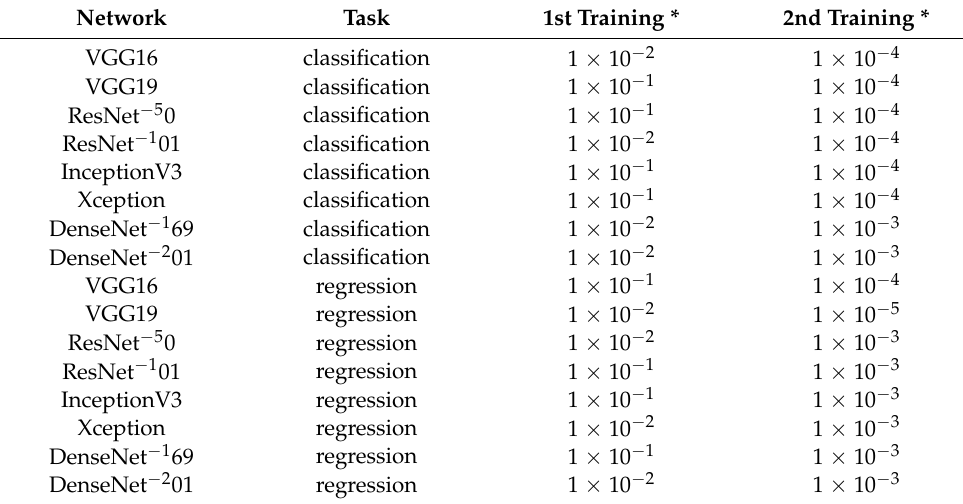
Table 1. Adam optimiser learning rates used in transfer